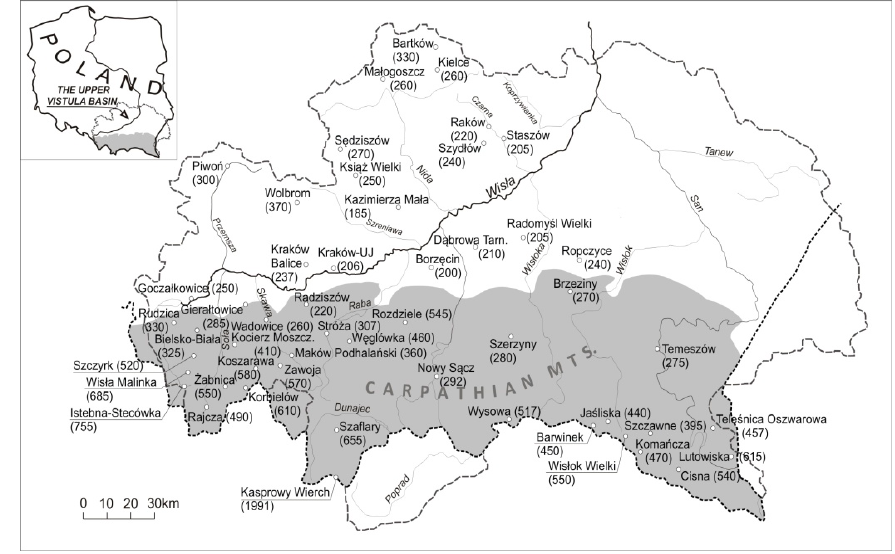
Figure 1. Location of the Upper Vistula Basin and weather stations (number indicates the elevation of station in meters above sea level).